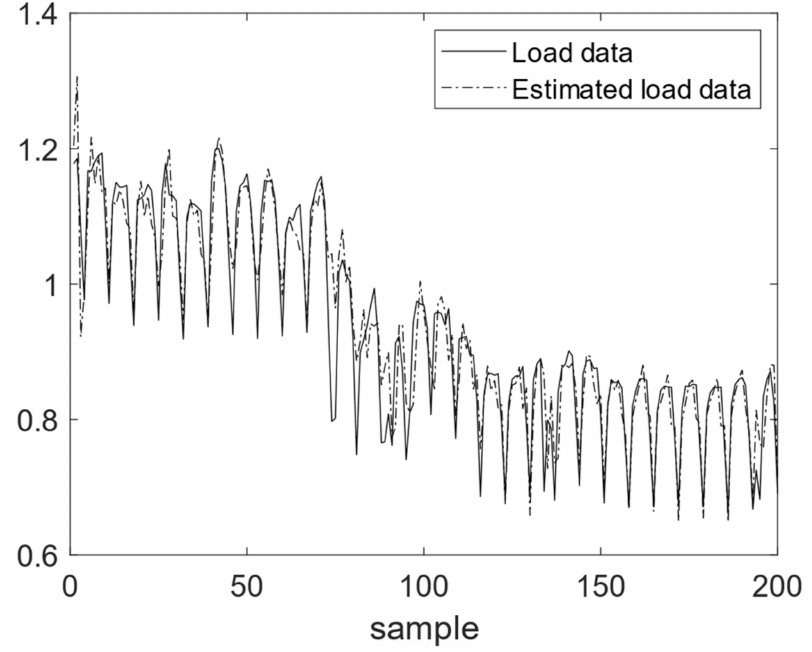
Figure 6. Performance of the proposed prediction method for the Poland electrical load dataset (test